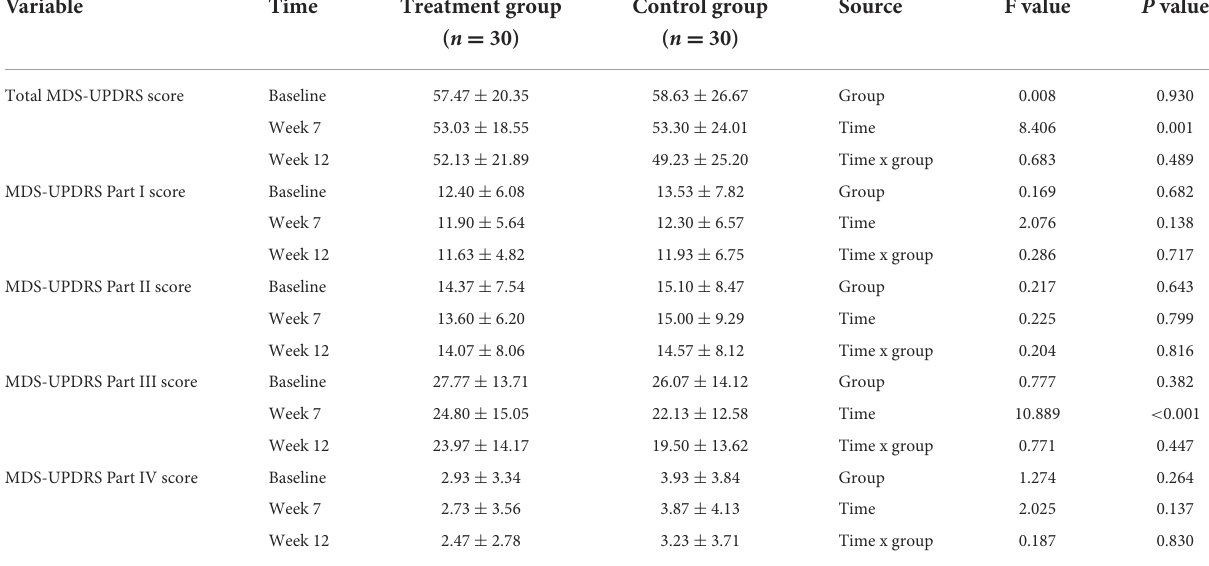
TABLE 4 The trend of changes during 12 weeks in the MDS-UPDRS score between groups depending on the time using repeated measures analysis of variance.